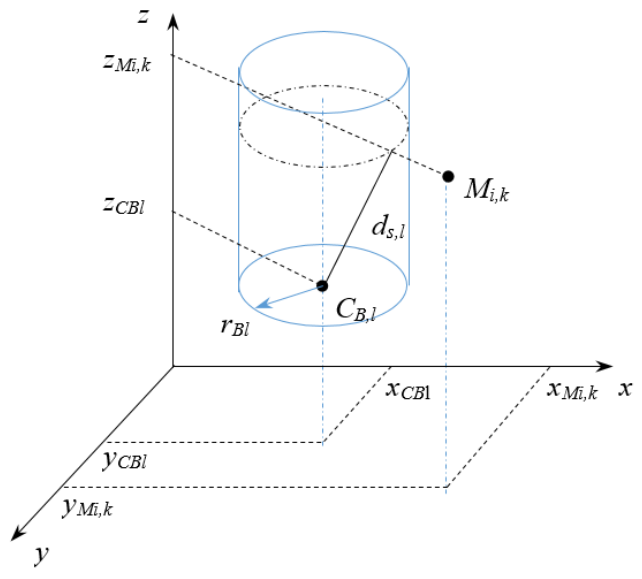
Figure 16. Obstacle representation and safe distance